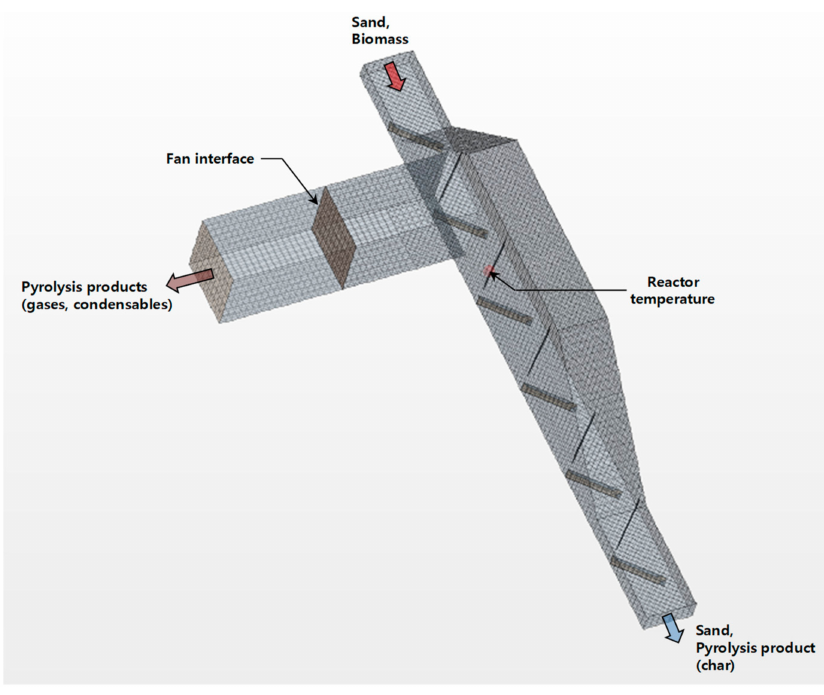
Figure 3. Calculation domain and